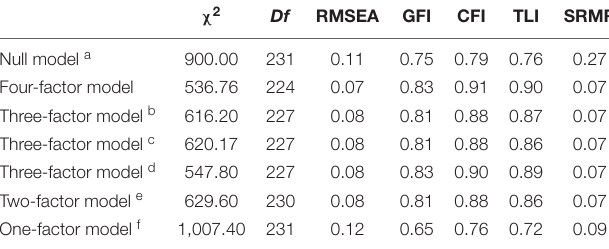
TABLE 2 | Results of confirmatory factor analysis for the measures of the variables studied. χ 2 Df RMSEA GFI CFI TLI